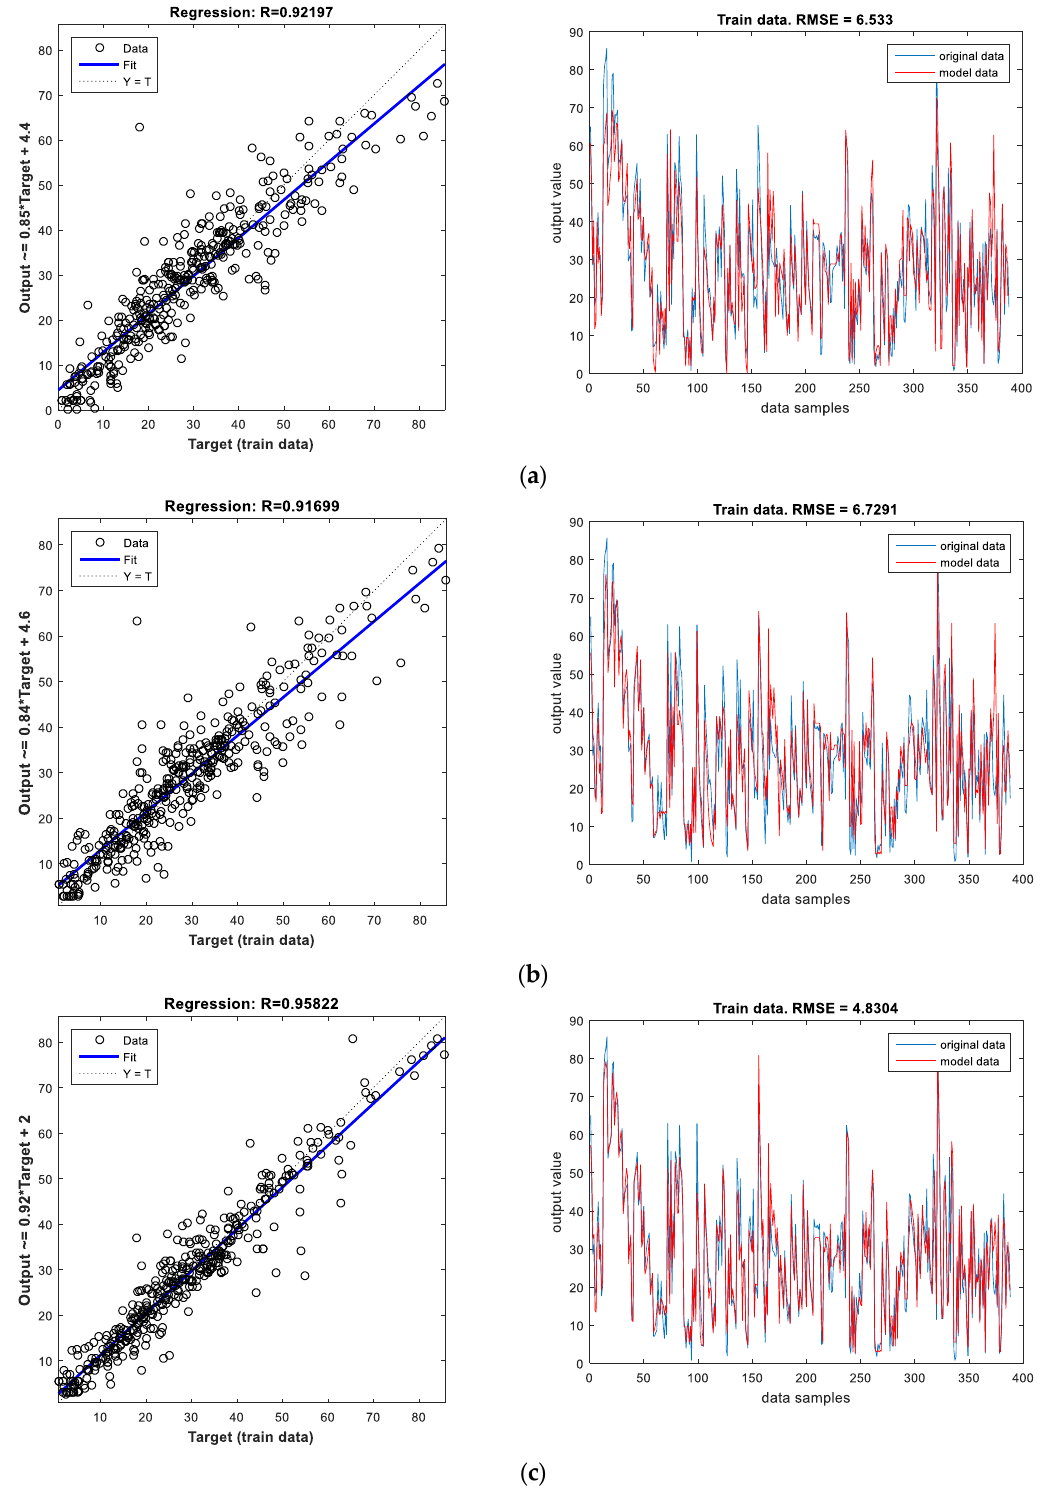
Figure 7. Performance evaluation using the train dataset for ANN models with ( a ) one hidden layer and ten neurons in the hidden layer, ( b ) two hidden layers having seven and two neurons respectively, ( c ) three hidden layers having nine, three and two neurons respectively.